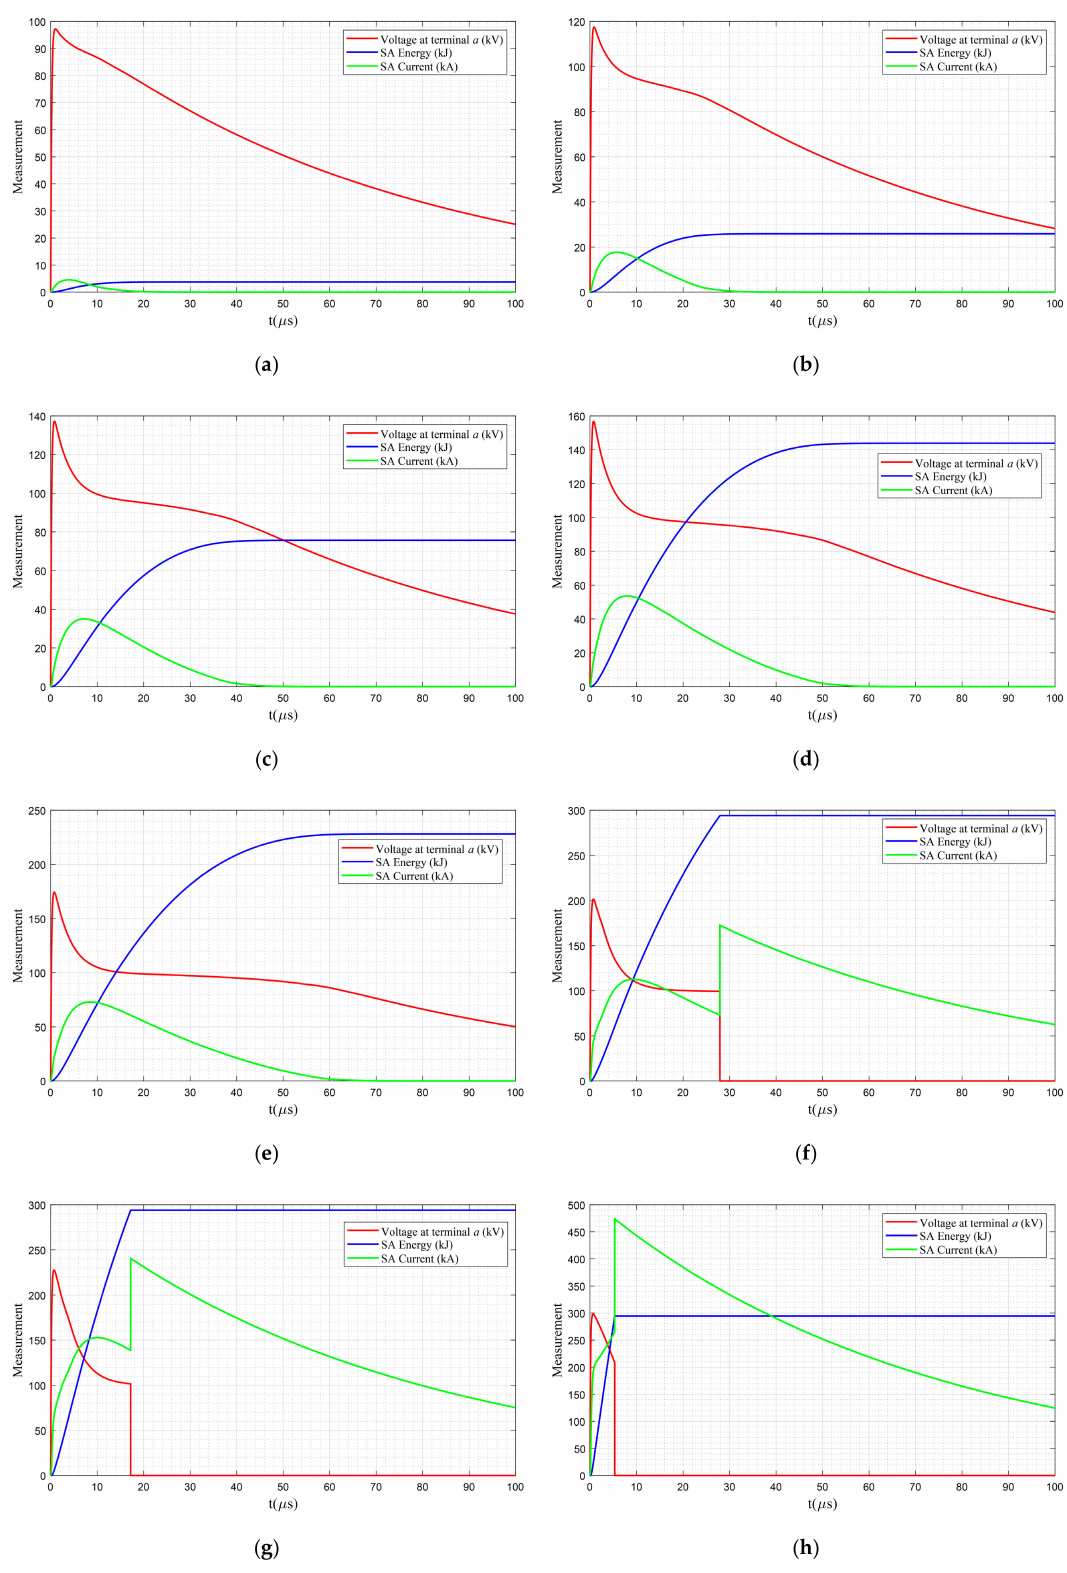
Figure 8. Performance of surge arrester SA-42b under lightning impulse voltage ( a ) 100 kV, ( b ) 125 kV, ( c ) 150, ( d ) 175 kV, ( e ) 200 kV, ( f ) 250 kV, ( g ) 300 kV, and ( h ) 500